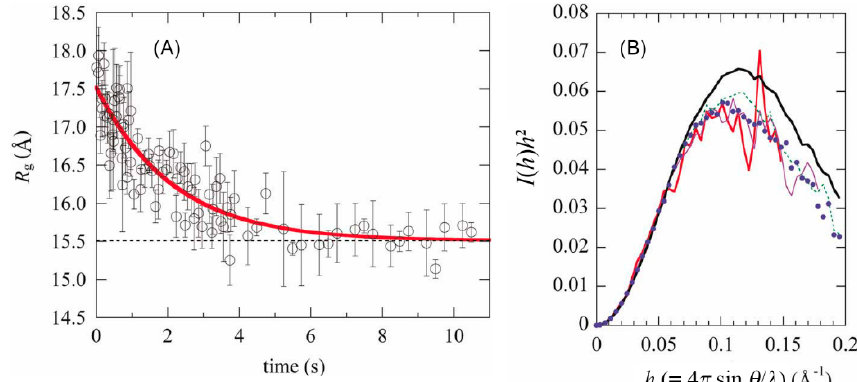
Figure 2. Time-dependent changes in the R g during the refolding of α -lactalbumin ( A ), and the Kratky plots of the protein during the refolding ( B ). The refolding was induced by a concentration jump of GdmCl from 4 M to 0.77 M in the presence of 1 mM CaCl 2 (pH 7.0 and 4.5 °C). ( A ) The time-dependent changes in R g2 were fitted to a single-exponential function, and the fitting curve of R g thus obtained is shown as a thick red line. The dotted line shows the R g value after the refolding is completed, and errors are the standard errors in fitting of Guinier plots. ( B ) The Kratky plots averaged between 10 and 20 ms after the initiation of refolding (red thick line), between 10 and 110 ms (purple line), between 10 and 960 ms (green dotted line), and between 8 and 11 s (black thick line). Blue filled circles show the Kratky plot of the equilibrium MG state at pH 2. The scattering intensities of each plot are normalized with the respective zero-angle intensities. Reproduced with permission from [31].